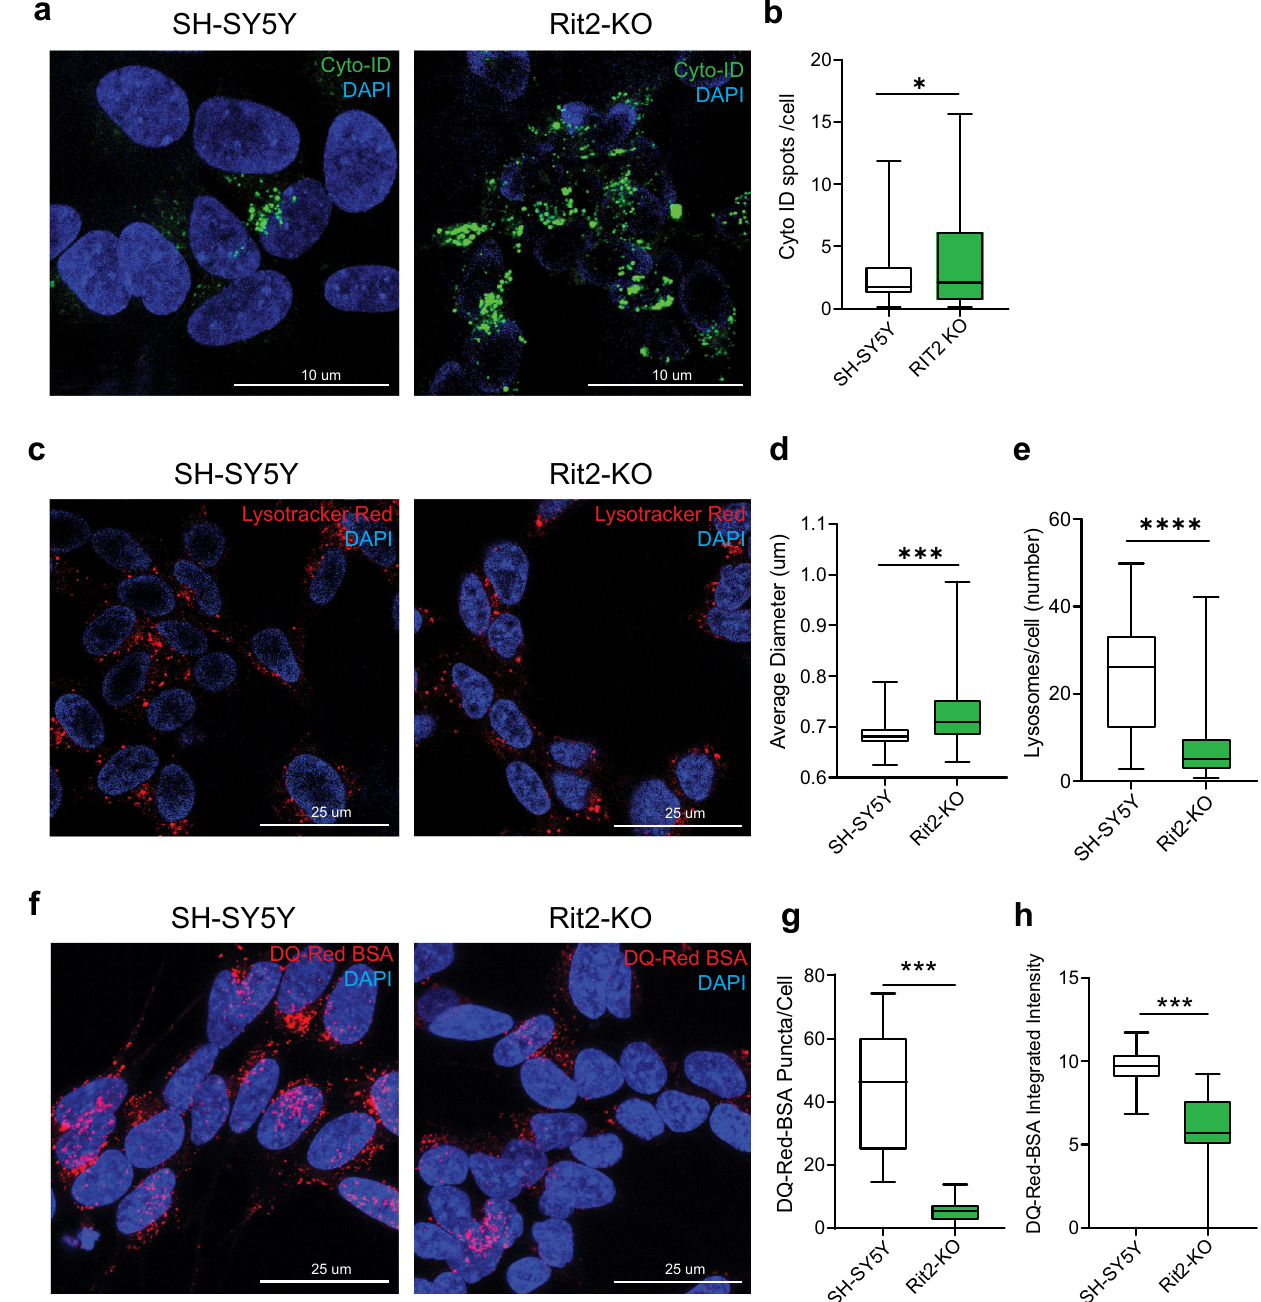
Fig. 8 Lysosomal morphology and proteolytic activity are altered in Rit2 KO neuroblastoma cells. a CytoID assay was employed to visualize autophagosome and autolysosome distribution. b Quanti fi cation of CytoID-positive puncta revealed a signi fi cant increase in Rit2-KO cells ( n = 3). c Cell processing with the Lysotracker Red dye was performed to visualize number and size of lysosomes. d The number of lysosomes per cell was quanti fi ed and revealed a decrease, with Rit2 KO ( n = 6). e The average size of lysosomes was assessed, and a signi fi cant increase of the diameter was measured in Rit2-KO cells ( n = 6). f The DQ-Red-BSA assay was employed to assess the proteolytic activity of lysosomes. g , h Quanti fi cation of DQ-Red-BSA fl uorescent spots revealed a signi fi cant decrease of number and intensity in Rit2-KO cells ( n = 3). Data are represented as median, boxes show the IQ and whiskers show min – max. In imaging experiments, analysis was conducted on 700 – 1000 cells per group in each experiment. * p < 0.05, *** p < 0.001, **** p < 0.0001 unpaired two-tailed Student ’ s t viral expression. In addition, the G2019S-LRRK2 mutation increases loss of DA neurons and striatal DA terminals in mice. Moreover, the recruitment of endogenous aSyn into pathological inclusions total aSyn levels and pS129-aSyn pathology were reduced by Rit2 and having a smaller impact on total aSyn levels 25 . In summary, in vivo. In our cell model, total levels of aSyn were not changed, but pathological pS129-aSyn was strongly reduced. This might be our results suggest that enhanced Rit2 expression has speci fi c due to the cellular model, with overall low endogenous levels of bene fi cial effects on aSyn inclusion clearance, rather than a total aSyn protein, whereas in vivo aSyn levels were high due to general effect on aSyn protein levels.